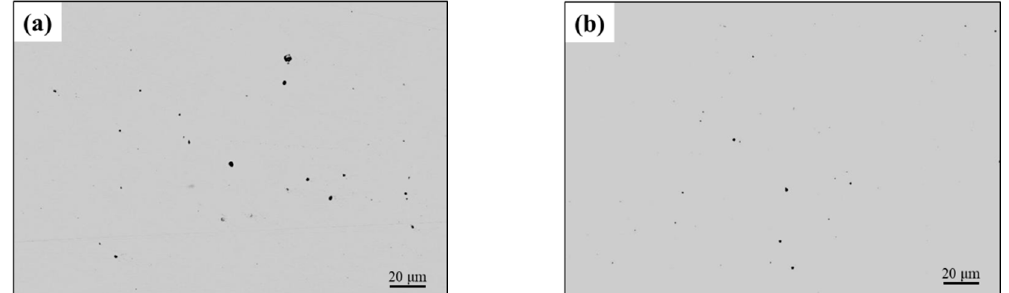
Figure 2. Distributions of inclusions in typical field of views with 500 magnifications in experimental steels. ( a ) 3Mg1Al; ( b ) 3Mg20Al.